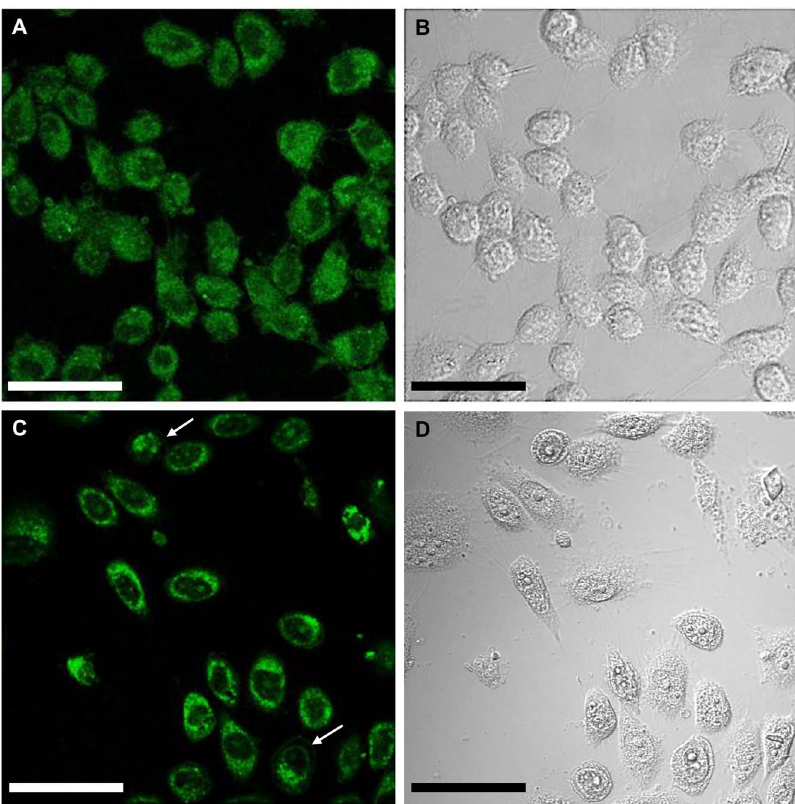
Figure 4. Confocal microscopy of ARP2 fusion protein expressed in CHO cells. CHO cells transfected with e gfp cDNA were observed 24 h post-transfection using confocal microscopy ( A ) and DIC microscopy ( B ). CHO cells transfected with arp2-egfp cDNA were also observed 24 h post- transfection using confocal microscopy ( C ) and DIC microscopy ( D ). Scale bar 50 m m. White arrows indicate cells that present ARP2 localized to the peri-nuclear